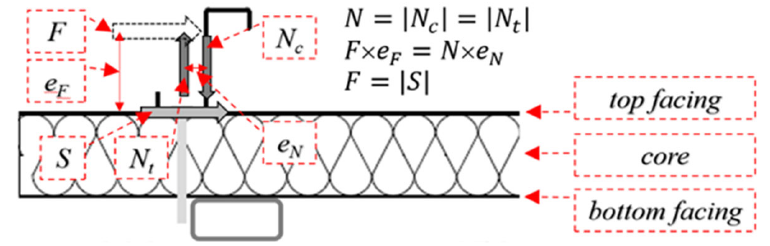
Figure 6. General scheme of the forces in the investigated connections.